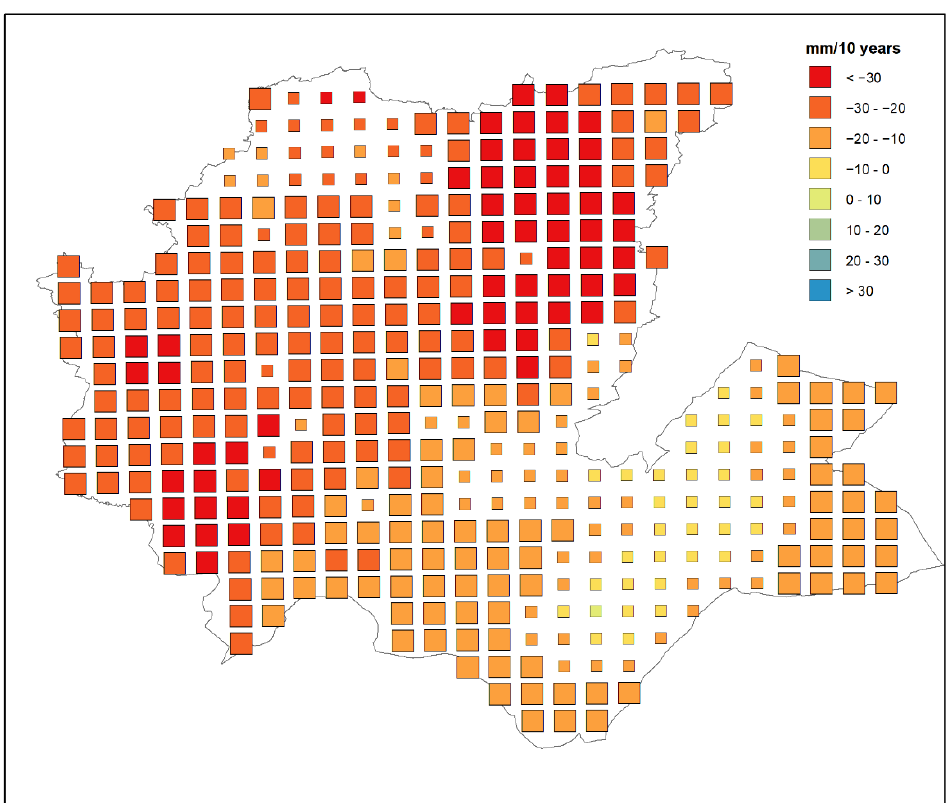
Figure 3. Percentages of grid points presenting positive or negative and significant or non-signifi- cant trends at yearly, seasonal and monthly time scales.